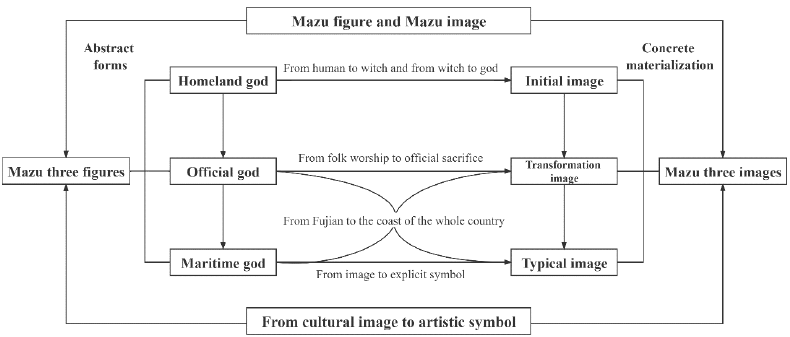
Figure 1. The relationship between the Mazu figure and the Mazu image. Source: Drawn by au- thor. 2. Figure of the “ Homeland God ” and the Initial Mazu Image